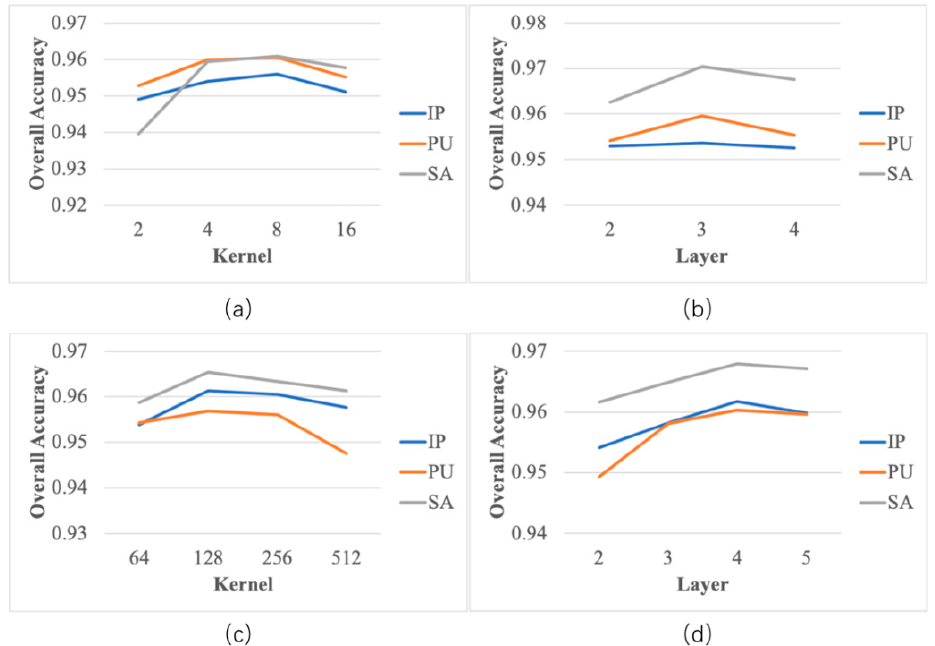
Figure 8. OA of the MSPN using different numbers of kernels and layers in each module. ( a ) The number of kernels in the multiscale 3D-CNN module. ( b ) The number of parallel layers in the multiscale 3D-CNN module. ( c ) The number of kernels in the pyramid pooling module. ( d ) The number of parallel layers in the pyramid pooling